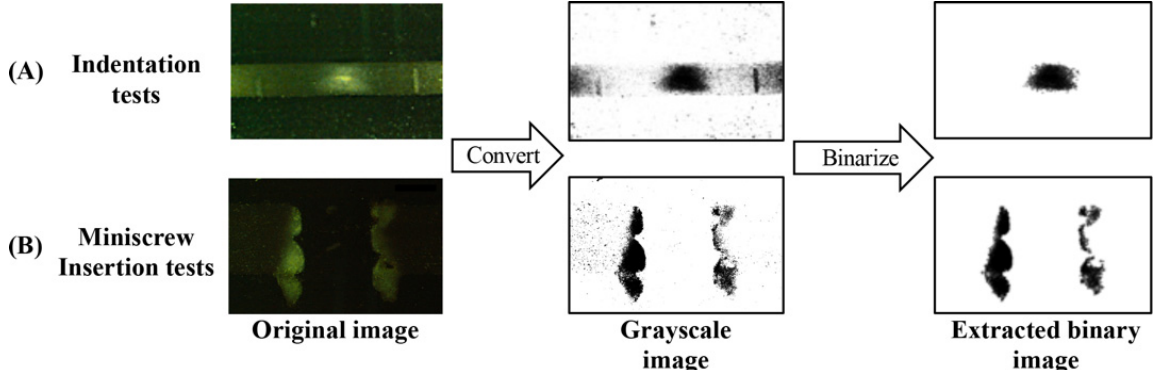
Figure 2. The procedure to extract stress-whitened areas of the synthetic bone using Image J software. ( A ) indentation tests, ( B ) miniscrew insertion tests.